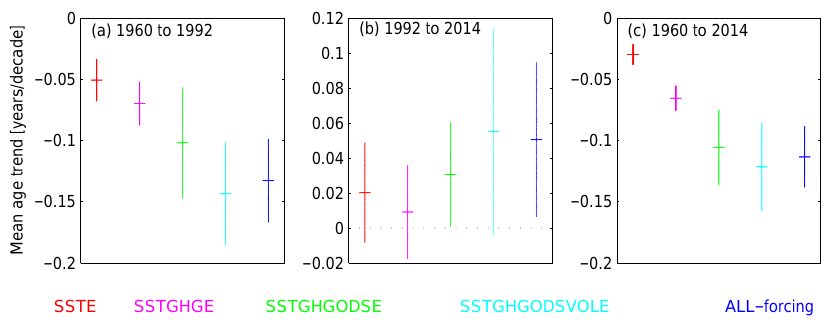
Figure 7. Trends in midlatitude NH mean age in the ensemble mean of each of the five experiments (a) from 1960 to 1992 and (b) from 1992 to 2014. The trend over the full duration of the experiments is shown in panel (c) . The horizontal line indicates the ensemble mean trend, and the vertical line indicates the 95% uncertainty bounds.